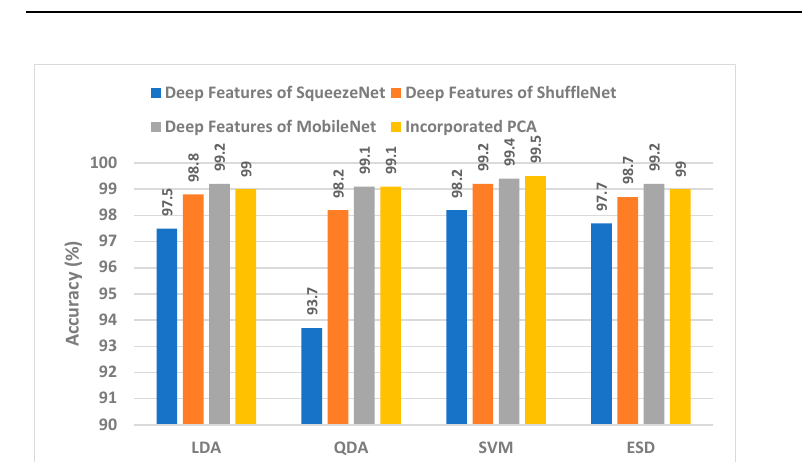
Figure 3. Classification accuracies (%) of deep features versus integrated PCA features of the three CNNs. Table 1. Classification accuracies (%) for several numbers of principal components after the PCA process conducted for the deep features of the three CNNs.